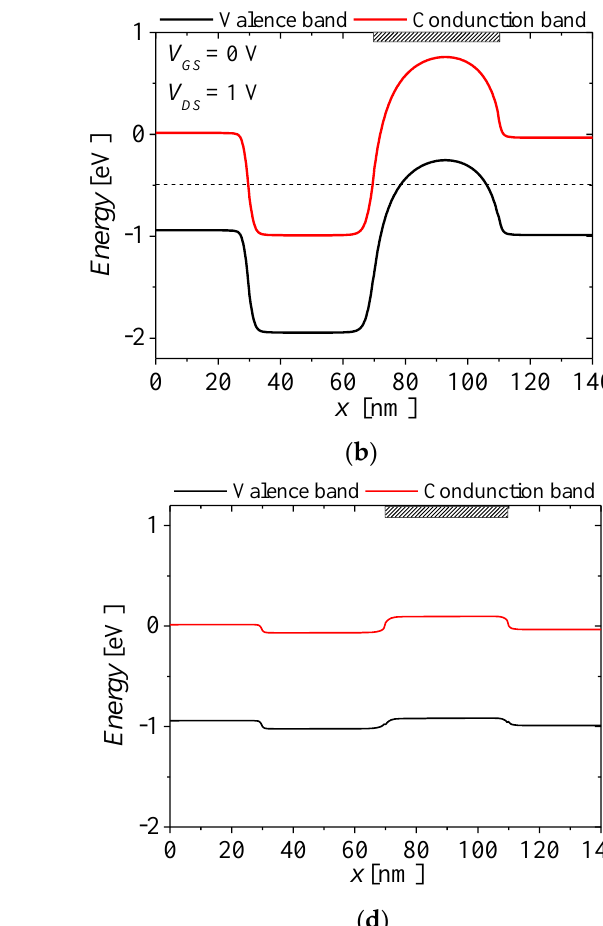
Figure 3. Drain − source current − gate − source voltage ( I DS - V GS ) characteristics of NFBFET at V DS = 1 V. 3. Tunneling Effect for the NFBFET The NFBFET has highly doped N-P junction in the channel region. When the V DS is applied to NFBFET such that the conduction band of the N-region and the valence band of the P-region are aligned, the BTBT can occur at N-P junction in the channel region, as shown in Figure 2b. Then, the BTBT currents make the carrier concentration in channel region change. Therefore, it is necessary to investigate the tunneling effect in the channel region. Figure 4 shows I DS - V GS characteristics of NFBFET at V DS = 1 V when the BTBT is con- sidered and ignored. The solid and dash lines denote simulation results considering and ignoring the BTBT, respectively. The leakage current considering BTBT increases about 10 4 times compared to ignoring BTBT when V GS = 0 V. As V GS increases, the conduction and valance bands of the gated channel region decrease, and then the BTBT current de- creases due to increase of tunneling length at N-P junction in the channel region.